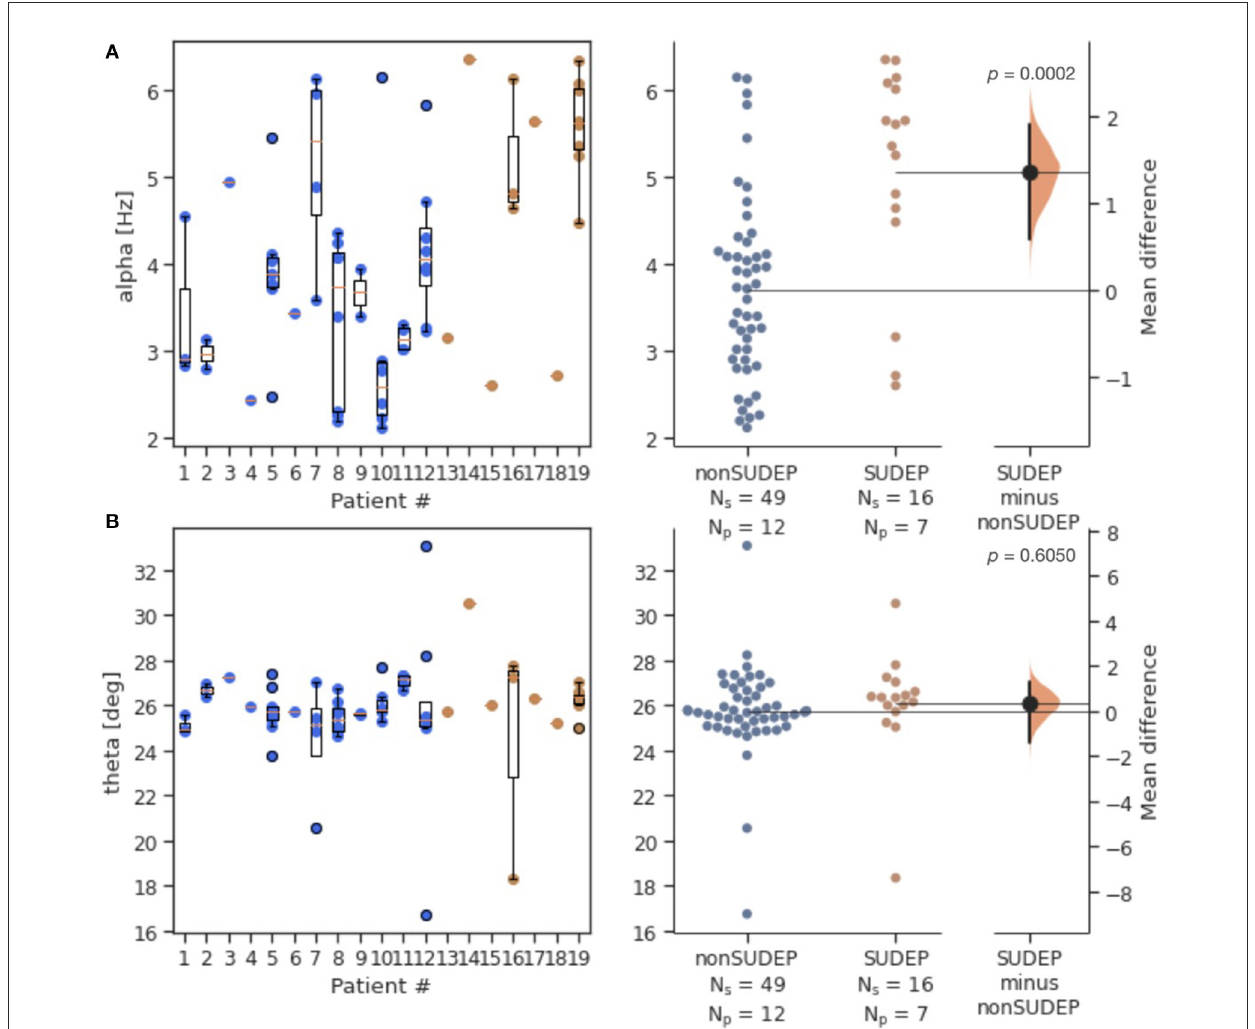
FIGURE2 Estimation statistics of both generalized and non-generalized seizures, comparing mid-seizure 20s windows for SUDEP vs. non-SUDEP populations. Population sizes indicated by N s (number of seizures), and associated N p (number of patients). Alpha metric (A) and theta metric (B) of the contour centroid. Blue dots represent seizures from non-SUDEP patients. Orange dots represent seizures from SUDEP patients. Pink horizontal bars are mean values by